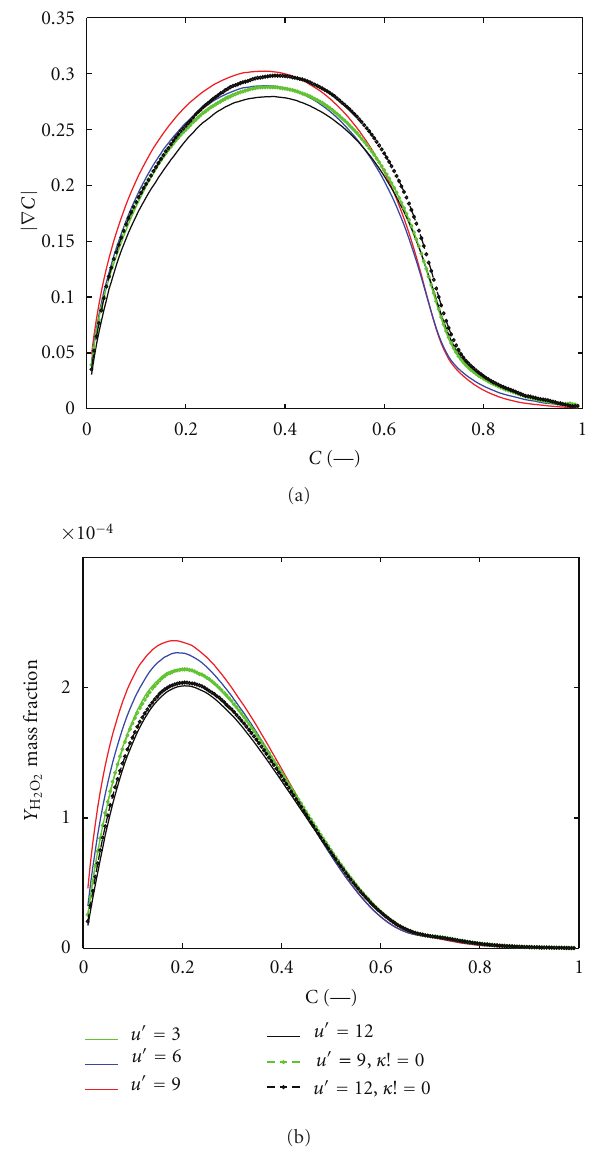
Figure 10: Conditional profiles of mean (a) progress variable gra- dient, |∇ C | and (b) mass fraction of H 2 O 2 , conditioned on the progress variable C at t = 1 . 2 τ